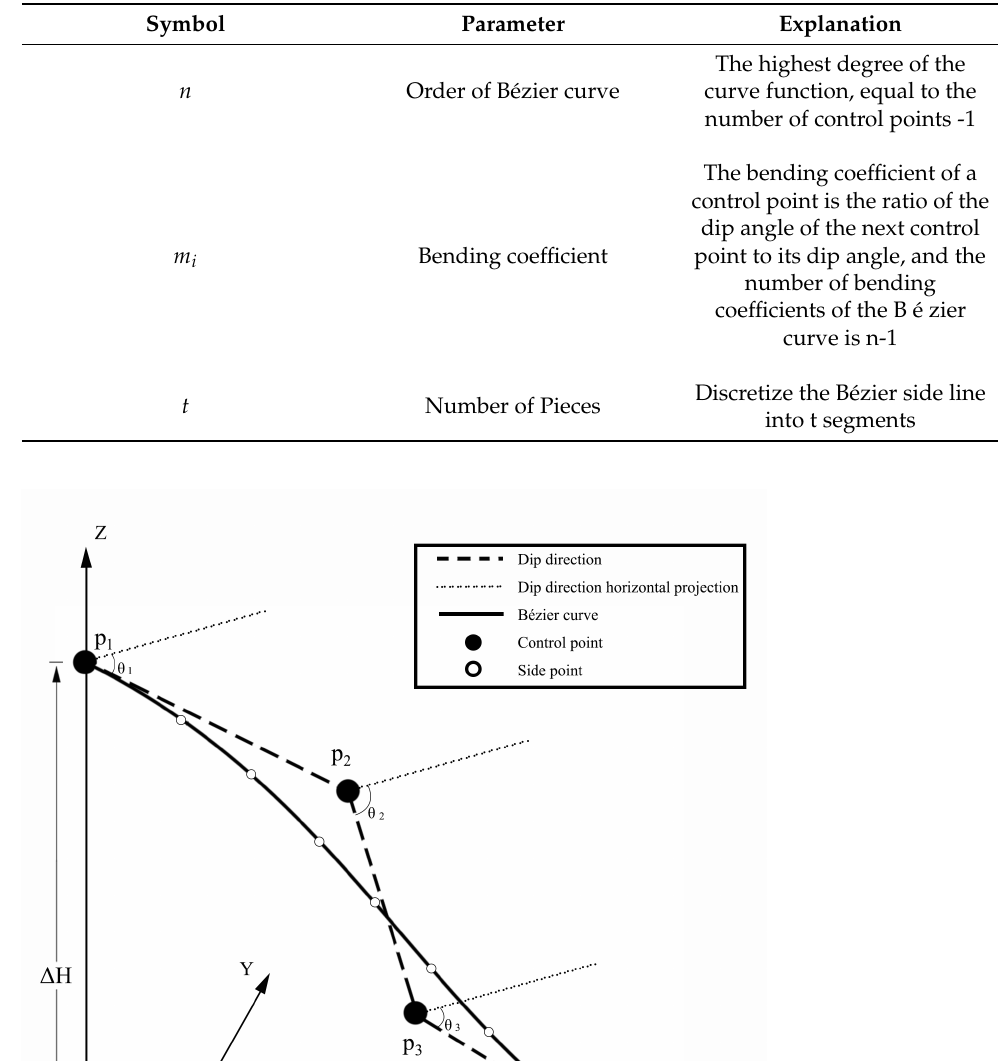
Table 3. Parameters of Bèzier curve.